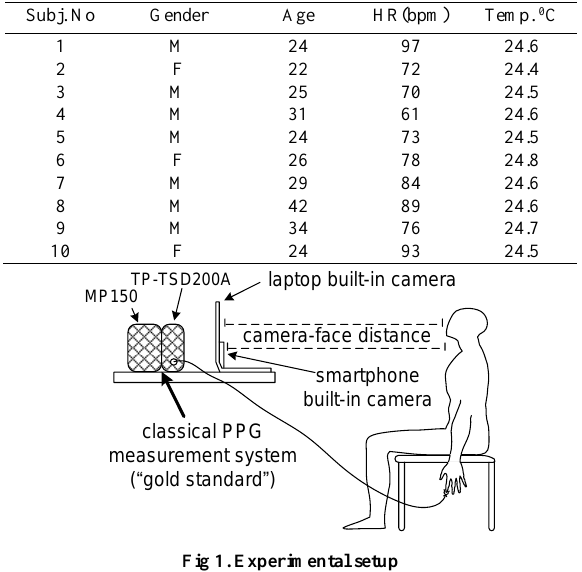
Fig 1. Experimental